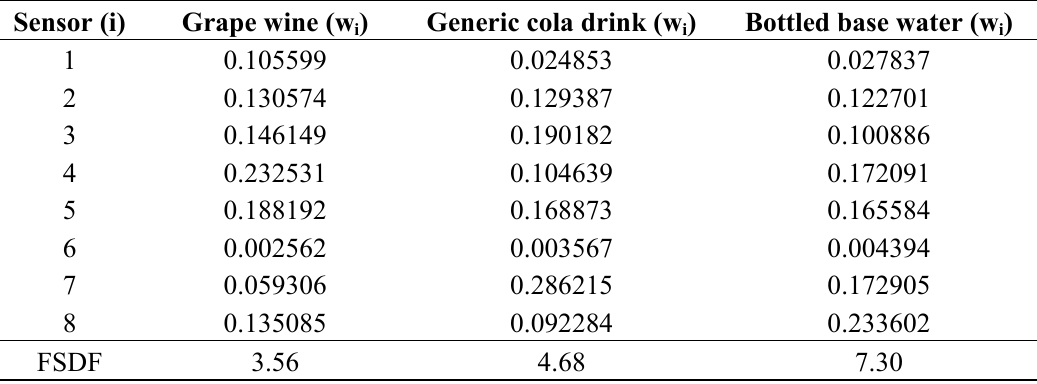
Table 4. The weighted coefficients of fuzzy set data fusion (FSDF) for every sensor and used the pH measured data of grape wine, generic cola drink and bottled base water drinks to obtain fusion results.